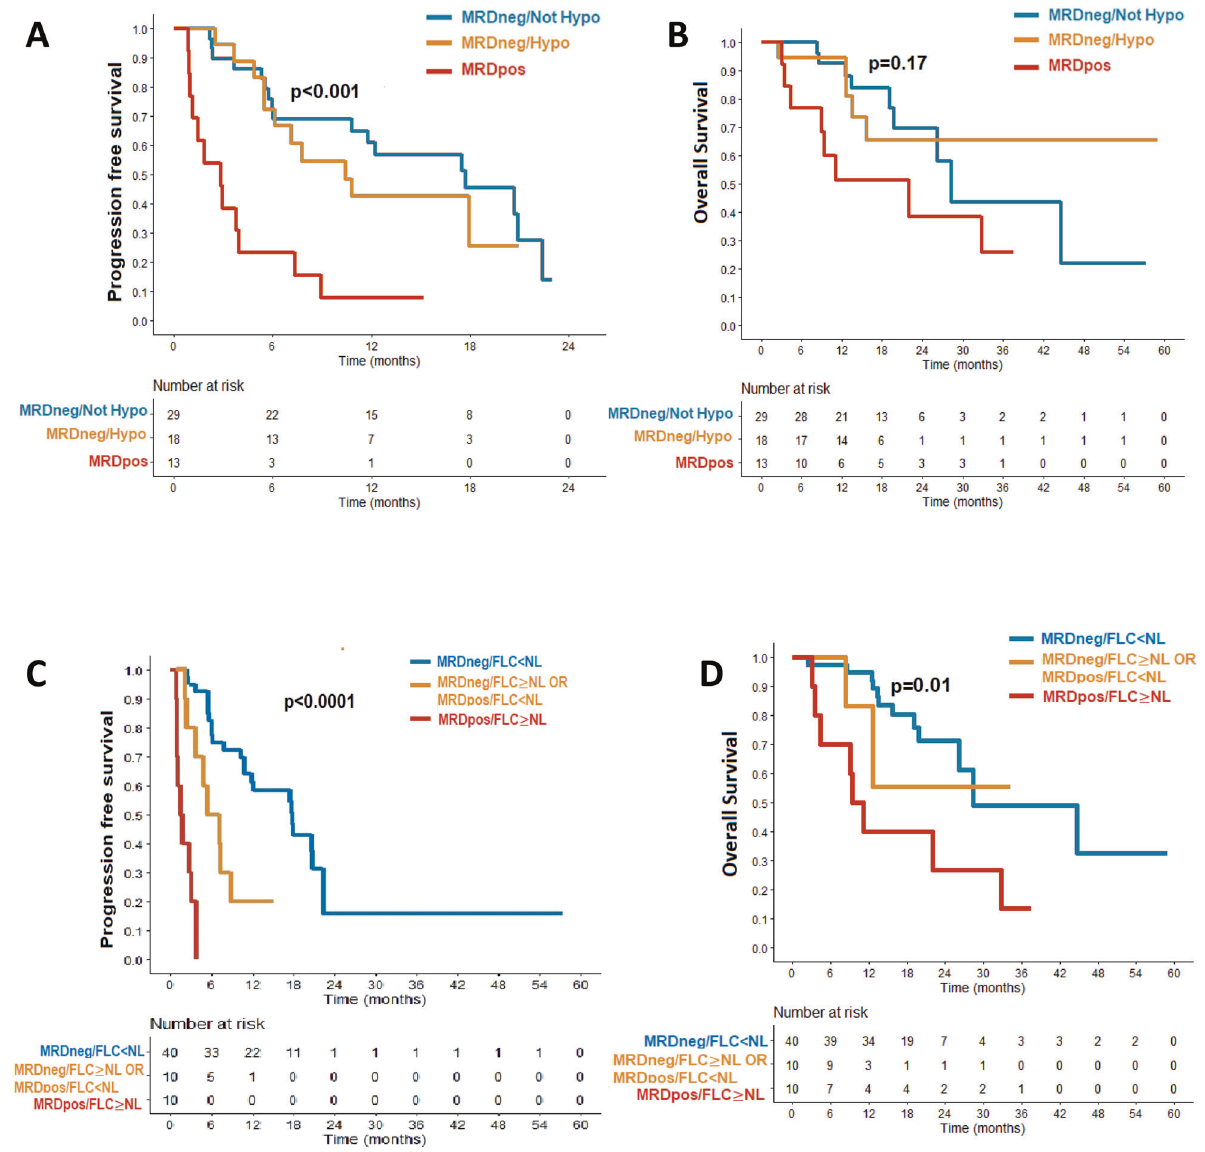
Fig. 2 Bone marrow MRD status and correlation with clinical outcome for patients with myeloma who received CAR-T. A Kaplan-Meier curve for progression free survival (PFS) between patients with month 1 BM MRDpos and MRDneg strati fi ed by BM cellularity (top left). B Kaplan-Meier curve for overall survival (OS) between patients with month 1 BM MRDpos and MRDneg strati fi ed by BM cellularity (top right ( C ) Kaplan-Meier curve) for PFS among patients with month 1 BM MRDneg/FLC < NL, MRDneg/FLC > = NL or MRDpos/FLC < NL and MRDpos/ FLC > = NL(bottom right). D Kaplan-Meier curve for OS among patients with month 1 BM MRDneg/FLC < NL, MRDneg/FLC > = NL or MRDpos/ FLC < NL and MRDpos/FLC > = NL (bottom